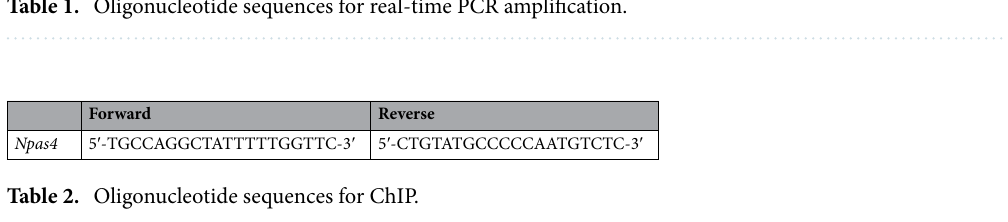
Table 1. Oligonucleotide sequences for real-time PCR amplification.